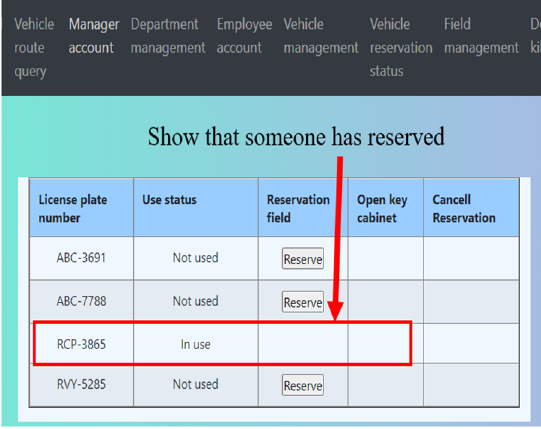
Figure 34. Vehicle reservation page.